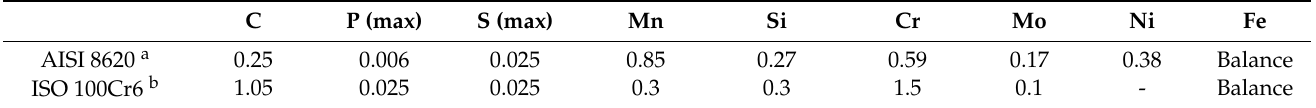
Table 1. Chemical composition (wt.%) of bearing steels.